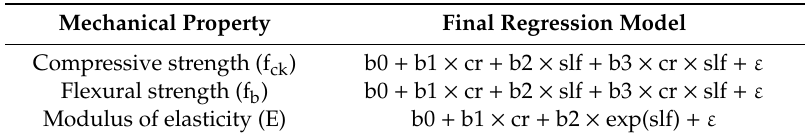
Table 8. Final regression models for the prediction of the mechanical properties with corresponding estimated regression equations.